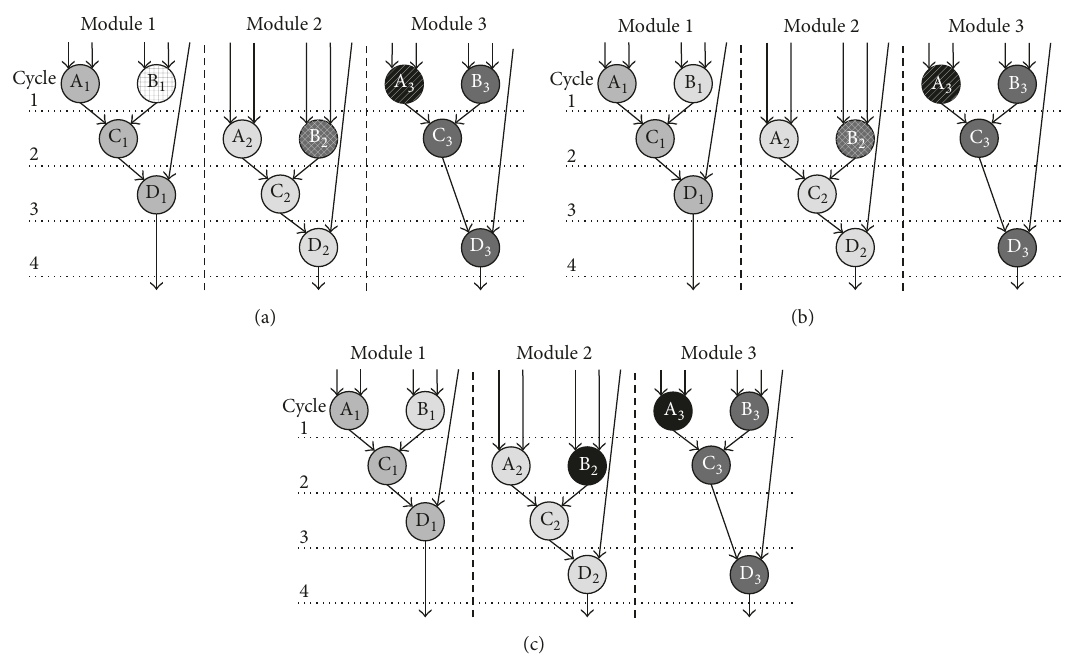
Figure 5: Sample binding for a latency constraint of 4 cycles and error constraint of 50%. The binding in (a) depicts the first stage of binding, whereas the bindings in (b) and (c) represent bindings following different steps in the second stage. The binding in (b) depicts the merging of a singleton with a nonsingleton, and the binding in (c) depicts the merging of a pair of